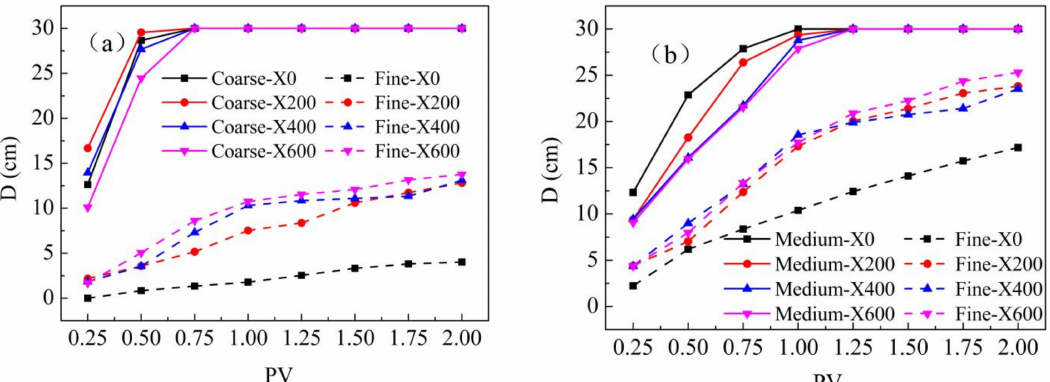
Figure 4. Variation on average maximum migration distance during injection of xanthan gum solution. ( a ) Coarse sand/fine sand; ( b ): medium sand/fine